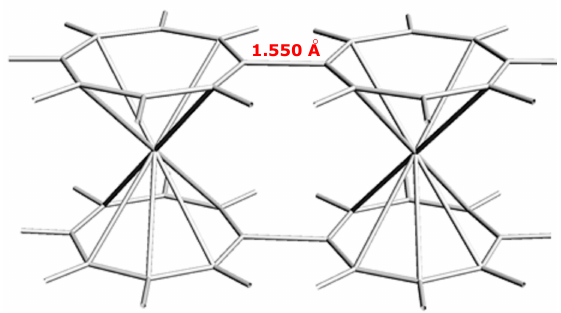
Figure 11. Molecular model for [U( η 8 -C 8 H 7 ) 2 ] 2 with D 2h symmetry [105]. Returning to the 5f 1 –5f 1 bis(imido) diuranium(V) systems [9], the ZORA/B3LYP